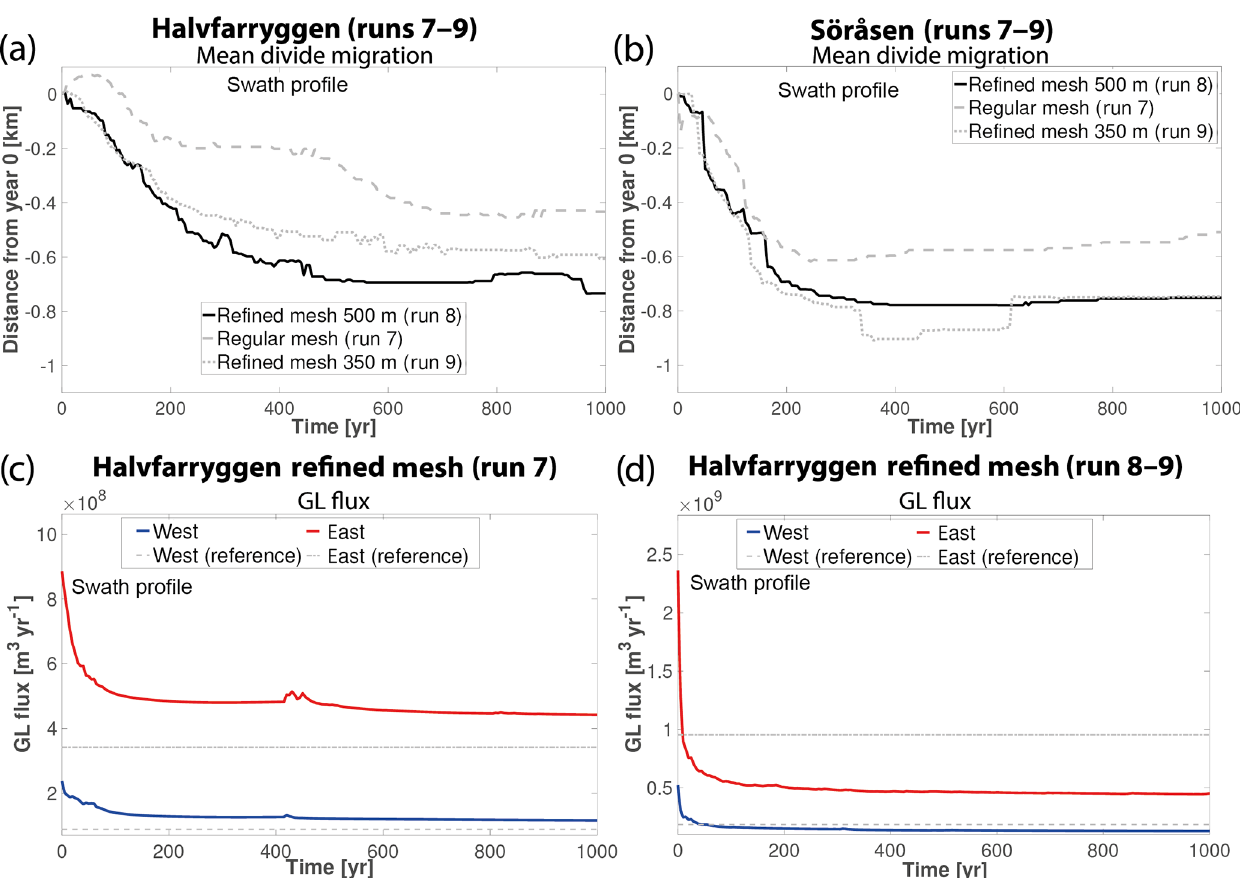
Figure 8. Ice-rise divide migration for (a) the Halvfarryggen Ice Rise and (b) the Söråsen Ice Rise induced by ocean perturbation (shelf removal) for different mesh resolutions. Negative numbers indicate migration to the west. Panels (c) and (d) show grounding-line (GL) fluxes for the eastern and western side of the divide to the grounding line for the Halvfarryggen Ice Rise. “Swath profile” indicates that computed divide migration is averaged over cross sections shown in Fig. 7. For the GL flux, this means that the flux is summed along the current grounding-line position over the swath length. Note different y -axis scales in (c) and (d)